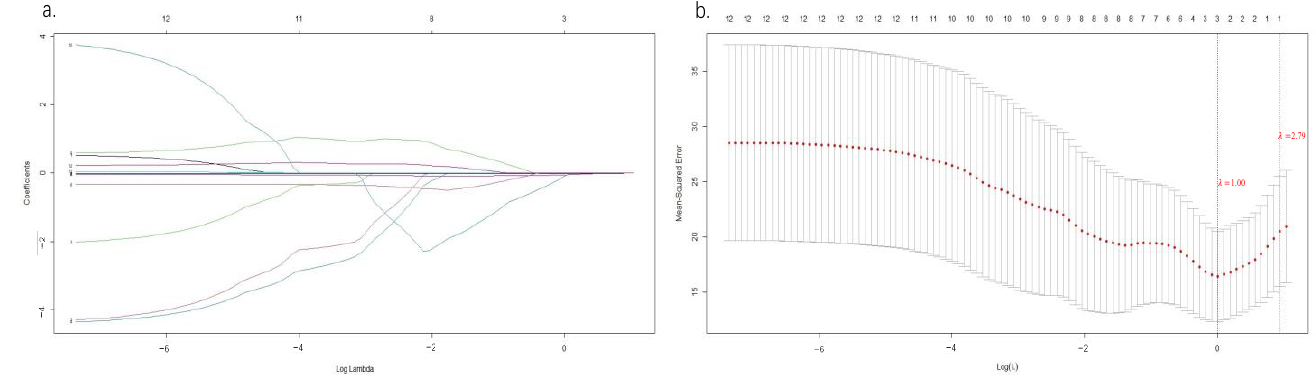
Figure 7. Lasso regression adjustment parameter process: ( a ) coefficient plot ( b ) parameter plot.